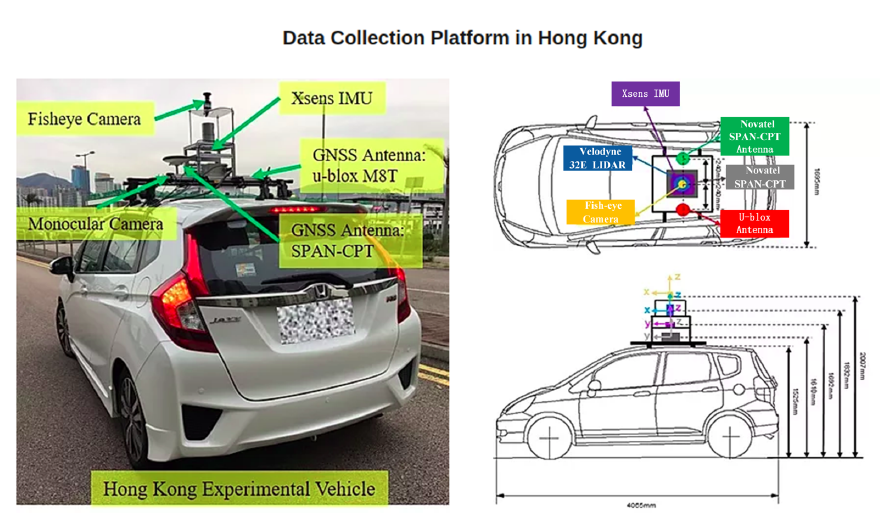
Figure 11. The platform for data collection in Hong Kong is a Honda Fit. All localization related sensors are equipped in a compact sensor kit on the top of the